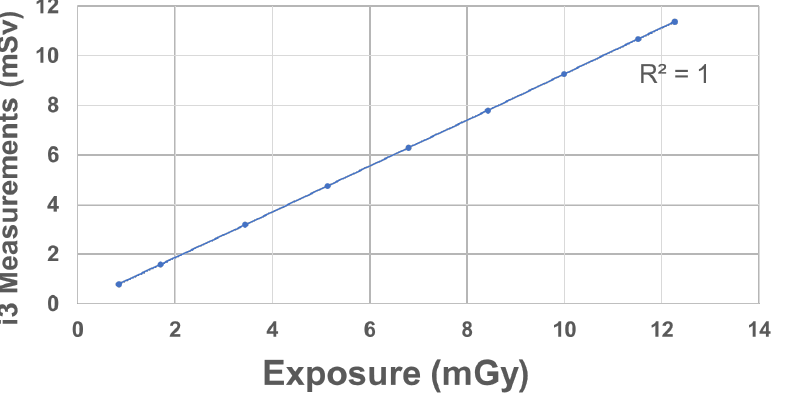
Figure 6. Dose linearities of the i3 system (vertical axis: i3 measurements; horizontal axis: ionization- chamber measurements).